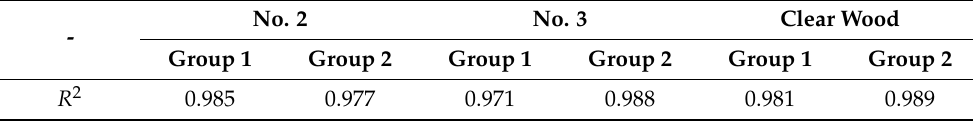
Table 3. Coefficient of determination R 2 of the verification.